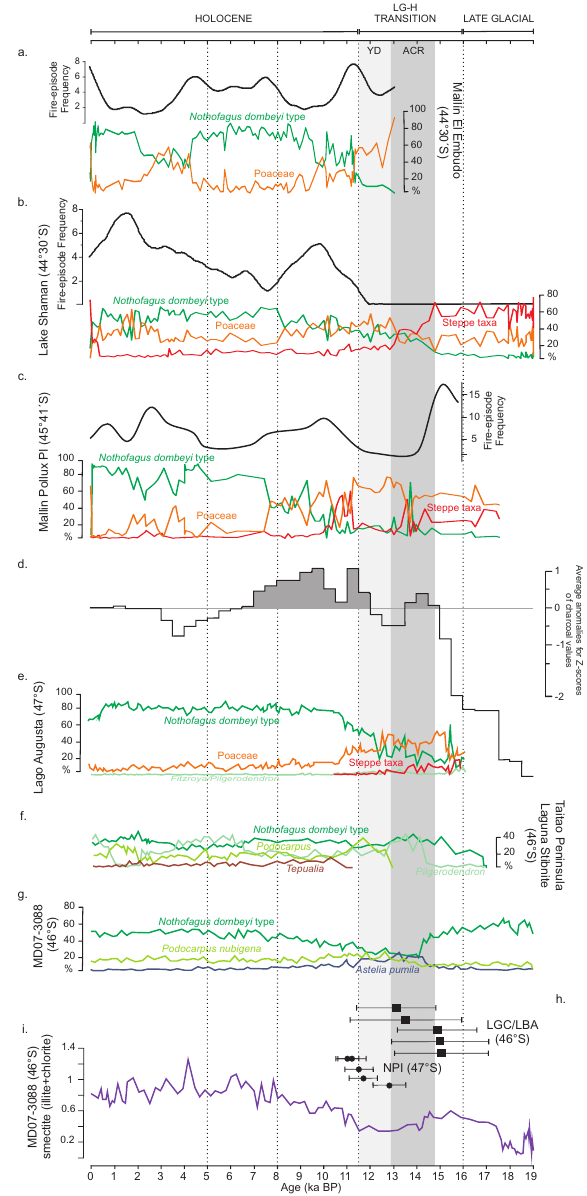
Figure 6. Integration of selected paleoenvironmental data from cen- tral Chilean Patagonia since the Late Glacial showing fire-episode frequency curve and summarized pollen diagram (%) from (a) Mal- lín El Embudo, (b) Lago Shaman (de Porras et al., 2012) and (c) Mallín Pollux (Markgraf et al., 2007); (d) summary of paleofire ac- tivity in western South America ( > 30 ◦ S, Power et al., 2008); sum- marized pollen diagram (%) from (e) Lago Augusta (Villa-Martinez et al., 2012); (f) Laguna Stibnite (Bennett et al., 2000) and (g) MD07-3088 marine core (Montade et al., 2013); (h) surface expo- sure ages of Late Glacial moraines at LBA/LGC (Douglass et al., 2006) and NPI (Glasser et al., 2012); (l) smectite/(illite + chlorite) index from MD07-3088 marine core (Siani et al., 2010). Grey ver- tical lines represent ACR and YD